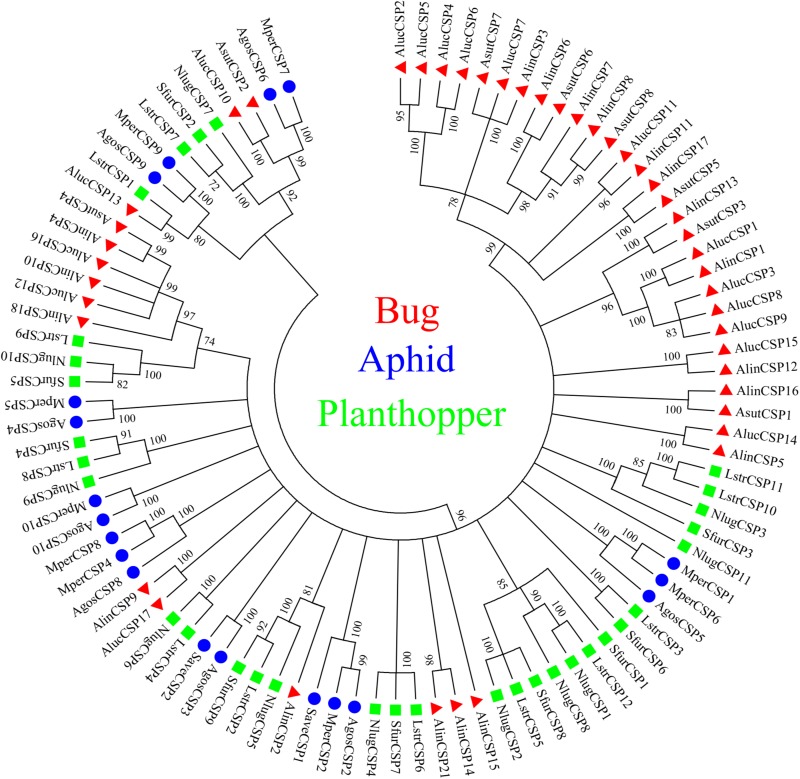
Phylogenetic analysis of CSPs. The CSP sequences used in this analysis are listed in Supplementary Table S4. Species abbreviations: Alin, Adelphocoris lineolatus; Aluc, Apolygus lucorum; Asut, Adelphocoris suturalis; Agos, Aphis gossypii; Mper, Myzus persicae; Save, Sitobion avenae; Sfur, Sogatella furcifera; Nlug, Nilaparvata lugens; Lstr, Laodelphax striatellus.